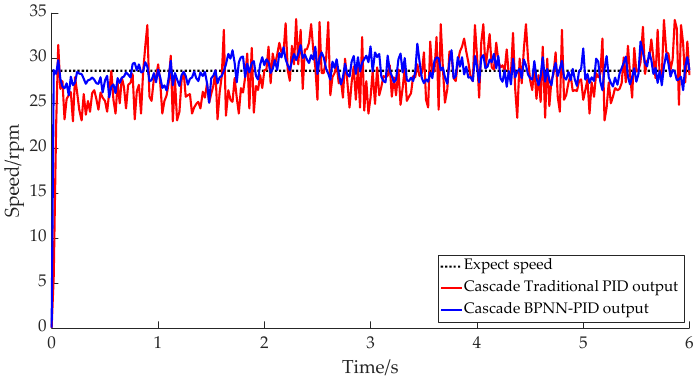
Figure 11. V-type collet-lifting mechanism actual speed outputs.